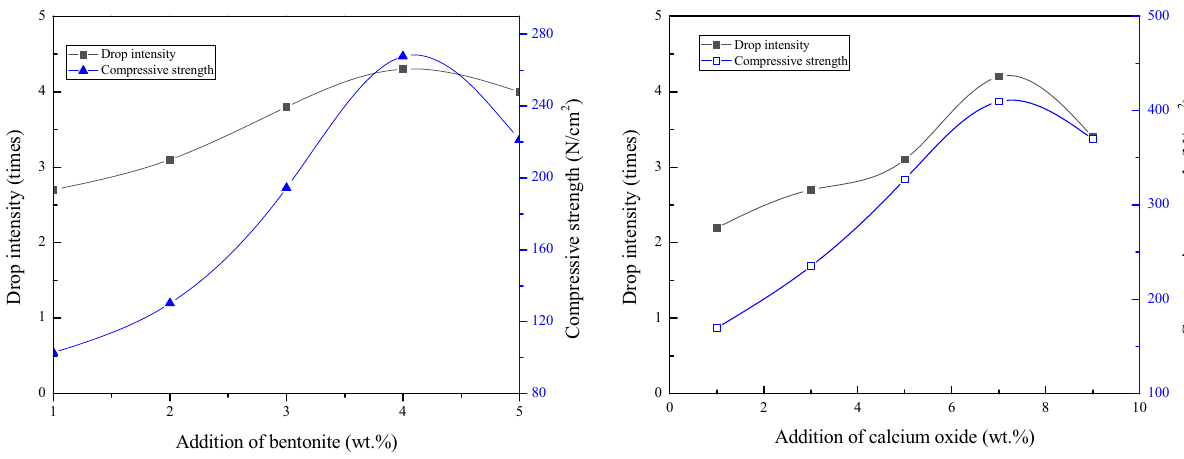
Figure 4: E ff ect of bentonite addition on the sample strength.